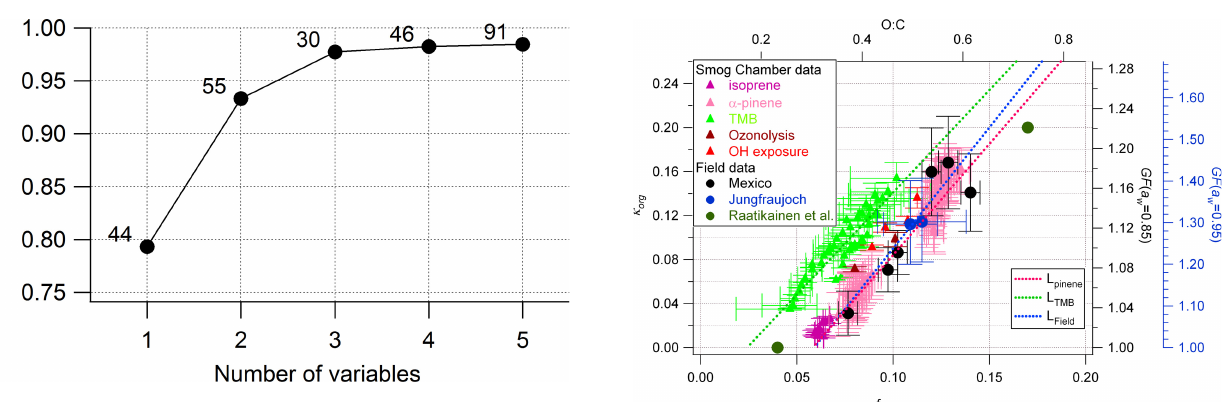
Fig. 7. Relationship between f 44 and κ org for field data (Jungfraujoch and Mexico City), smog chamber data (SOA formed from traditional photooxidation of isoprene, α -pinene and 1,3,5- trimethylbenzene, from the ozonolysis of α -pinene and subsequent OH exposure. Data of Raatikainen et al. (2010) are also shown. Lin- ear regression fits are shown for TMB ( L TMB ) , isoprene/ α -pinene ( L pinene ) and field data ( L field ) .